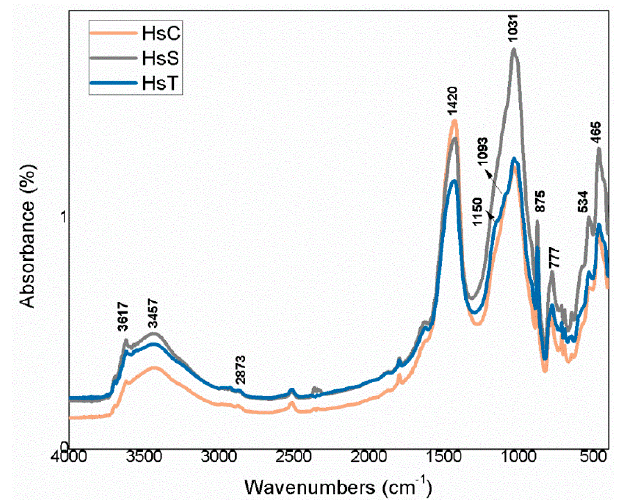
Figure 10. FTIR spectra for siliceous waste (Hs).